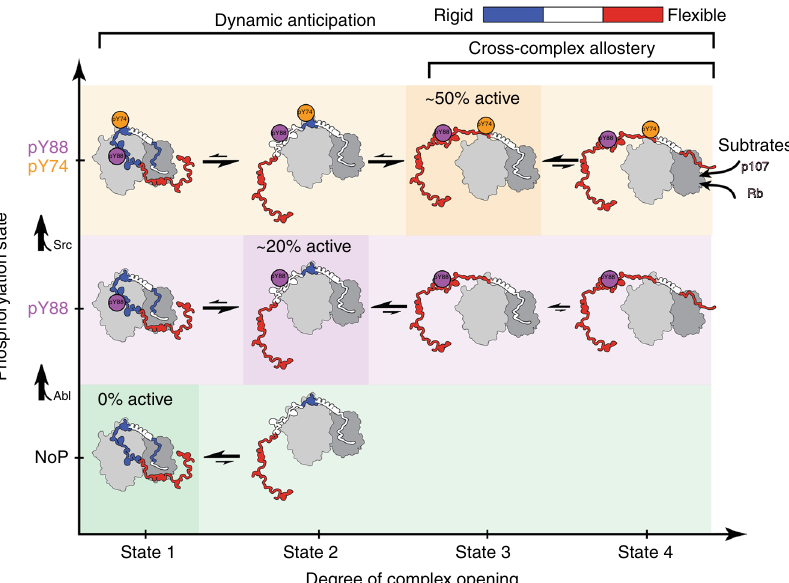
Fig. 6 Structural dynamics within Cdk2/cyclin A/p27 complex. p27 bound to Cdk2/cyclin A can be best described as a highly dynamic ensemble with multiple conformational states (approximated here by 4) in a multi-level energy landscape, whose structural properties and binding interfaces are tuned by the degree of phosphorylation. Prior to phosphorylation, Y74 and Y88 already sample solvent-exposed conformations that enable its phosphorylation by NRTKs (by Abl). Y88 phosphorylation (marked in purple) partially activates Cdk2. Additional Y74 phosphorylation (by Src, marked in yellow) causes displacement of subdomain D2 from Cdk2 (while preserving its local compact conformation), further kinase activation and intramolecular phosphorylation of T187, also facilitated by partial release of the substrate-binding region on cyclin A. Flexibility is color coded from rigid (blue) to fl exible